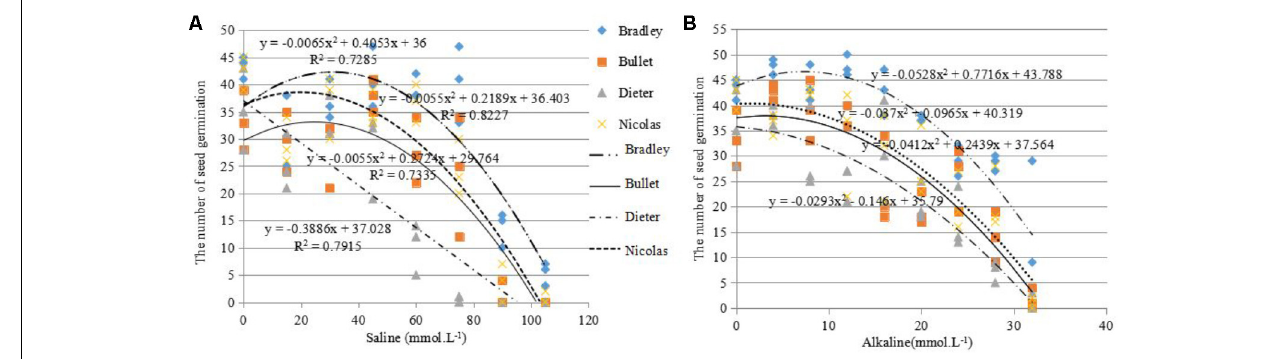
FIGURE 2 | Number of seeds germinated (out of 50) under different levels of salinity (A) and alkalinity (B) for four different oat cultivars: AC Bradley, AAC Bullet, AC Dieter, AAC Nicolas.